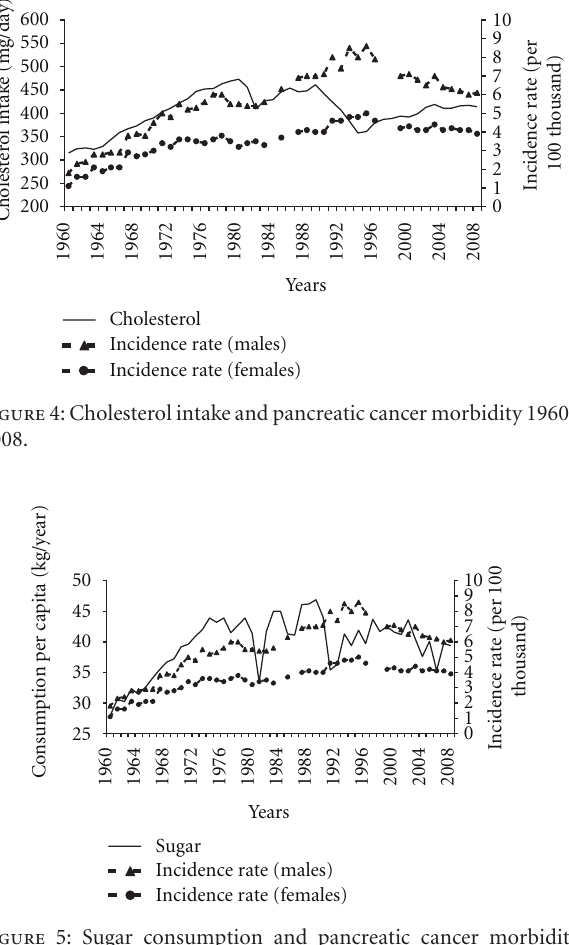
Figure 5: Sugar consumption and pancreatic cancer morbidity 1960–2008.